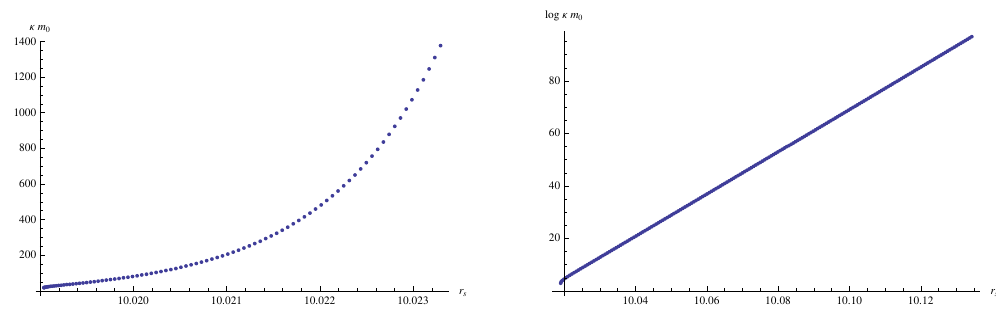
Figure 12 . Relation between ^ m 0 and r s for a 0 = 10 and (cid:11) = 0 : 05. The density m 0 increases exponentially as r s